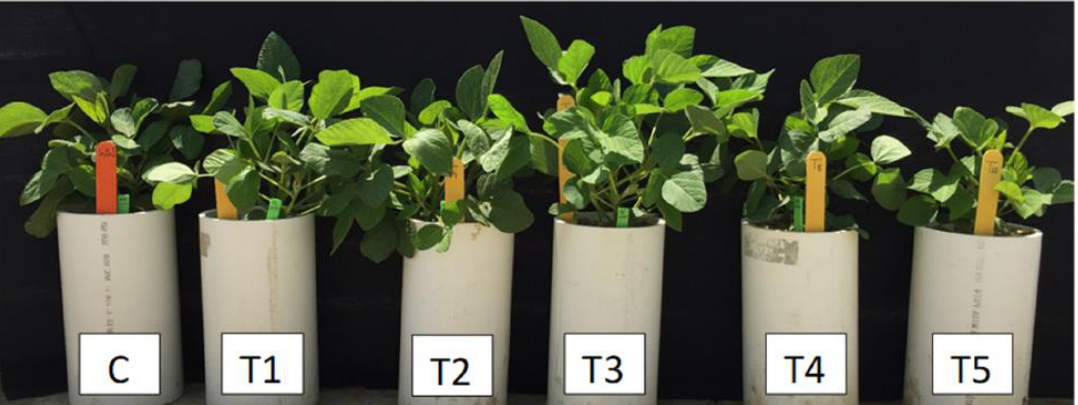
Figure 1. The effect of silicon on vegetative growth of soybean plants. Potassium silicate was incorporated into soils to give different silicon concentrations: T1 (50 ppm), T2 (150 ppm), T3 (500 ppm), T4 (1500 ppm), and T5 (2000 ppm). Asgrow 5332 soybean plants were grown in pots with soil and nutrient supply at natural light and temperature conditions for 45 days. The control pots (C) contained soils with added potassium chloride, which was used as a control to cancel the effect of potassium. 2.2. Effects of Silicon on Vegetative Growth of Soybeans (7 – 27 Days after Emergence) Grown under Water-Limiting Conditions